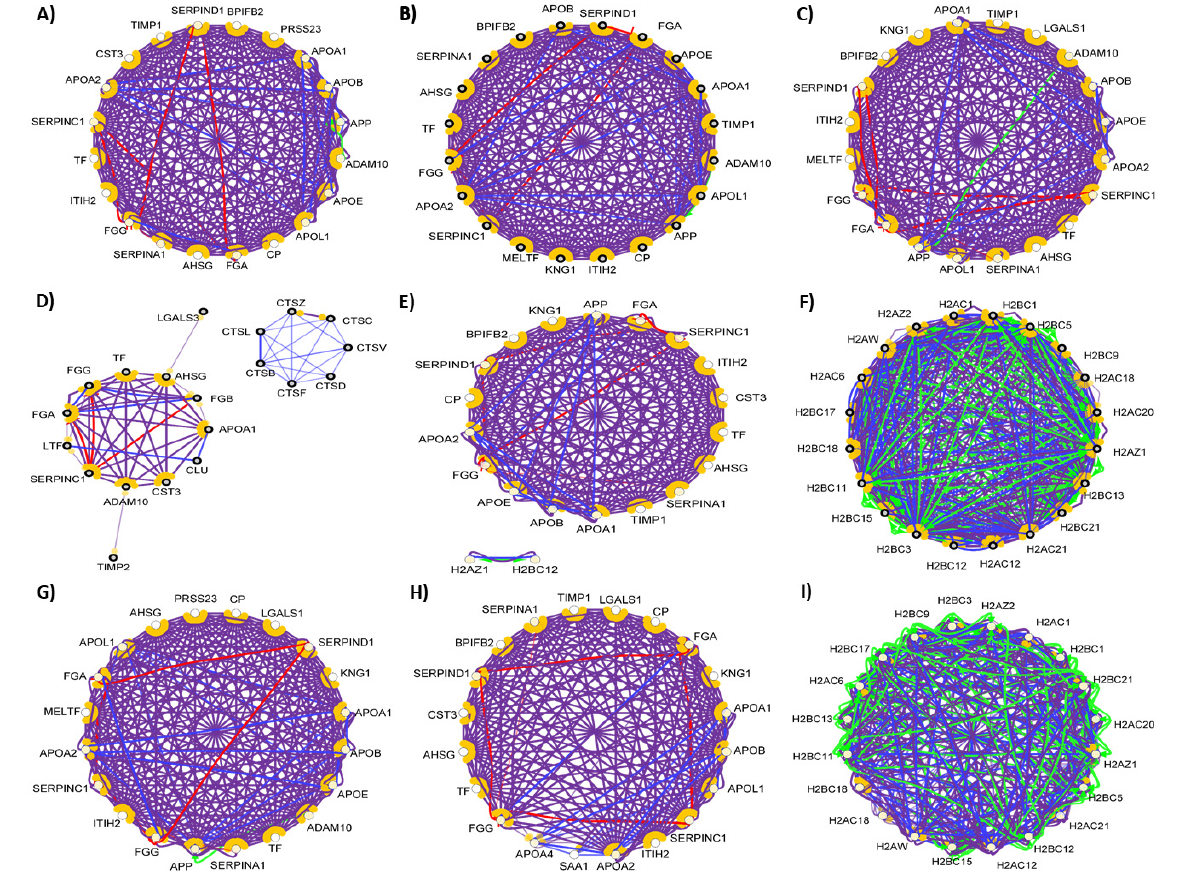
Figure 10. Interaction between the top 20 hub proteins in ( A ) serum, ( B ) tears, ( C ) saliva, ( D ) sweat, ( E ) nasal secretion, ( F ) urine, ( G ) CSF, ( H ) cervicovaginal fluid, and ( I ) seminal fluid. The blue lines represent binging, green lines represent activation, red lines represent inhibition, and purple lines represent catalysis. The proteins are labeled with their gene name.